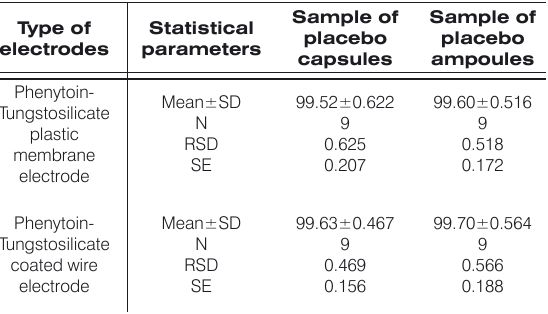
Table 5. Determination of phenytoin sodium in phenytin-spiked placebo samples using phenytoin-tungstosilicate sensors.